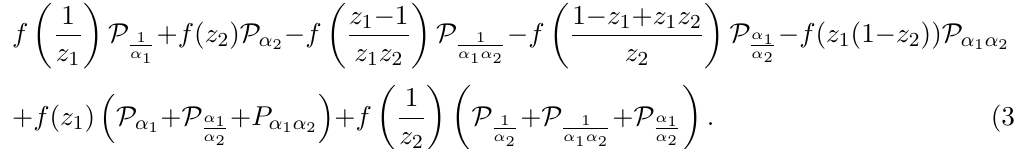
Figure 7 . Tessellation of a particular (cid:12)ve point function skeleton graph where we assumed l Notice that the con(cid:12)guration with all l ij non-zero has a non-planar topology. After tessellating a given skeleton graph one is instructed to insert a complete set of mirror particle states to glue the hexagons back, see the (cid:12)gure on the